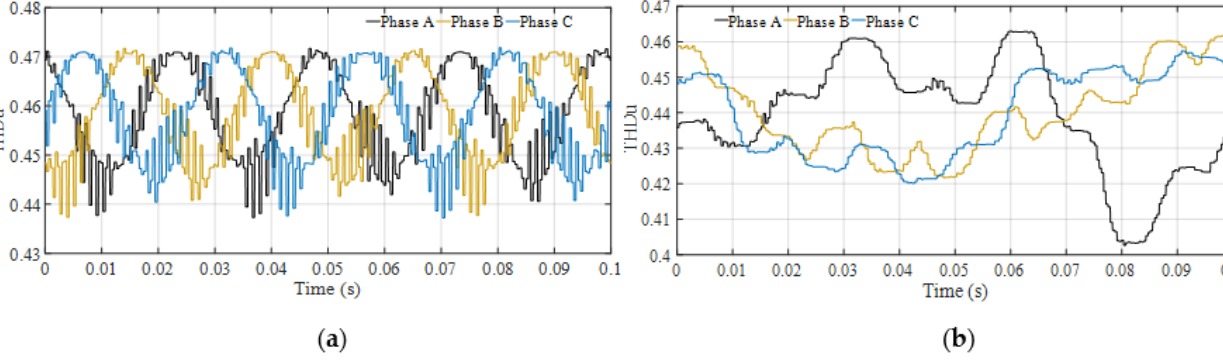
Figure 30. Total harmonic distortion of the voltage (THDu). ( a ) Deformed by harmonic and ( b ) operating EVs as active filter. Use case 4: Reactive Power Injection To regulate the reactive power based on grid-codes requirements, the EVs can be exploited to improve the power factor of the system. For example, according to the VDE 4105 code [47], it is required that the inverters are capable of feeding in with a displacement up to 0.95 leading or lagging and if the plant power exceeds 13.8 kVA, a displacement up to 0.90 must be supported. In this respect, the following case scenarios in Table 6 were tested in RTDS. Based on the simulation results shown in Figure 31, the system power factor was about 0.8 when the set points were adjusted based on scenario 1. However, by consuming the 200 kVA reactive power via the EV system, the power factor increased from 0.8 to 0.9 and satisfied the VDE 4105 code. Table 6. Test set points for the use case 4. Scenario